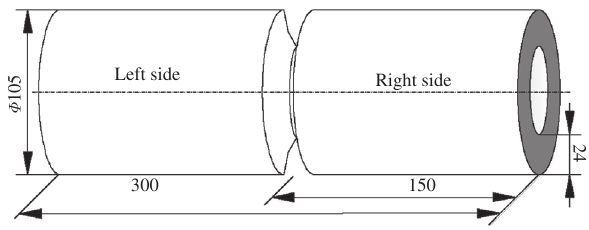
Figure 1: Geometry of multi-pass butt-welded P92 pipe.